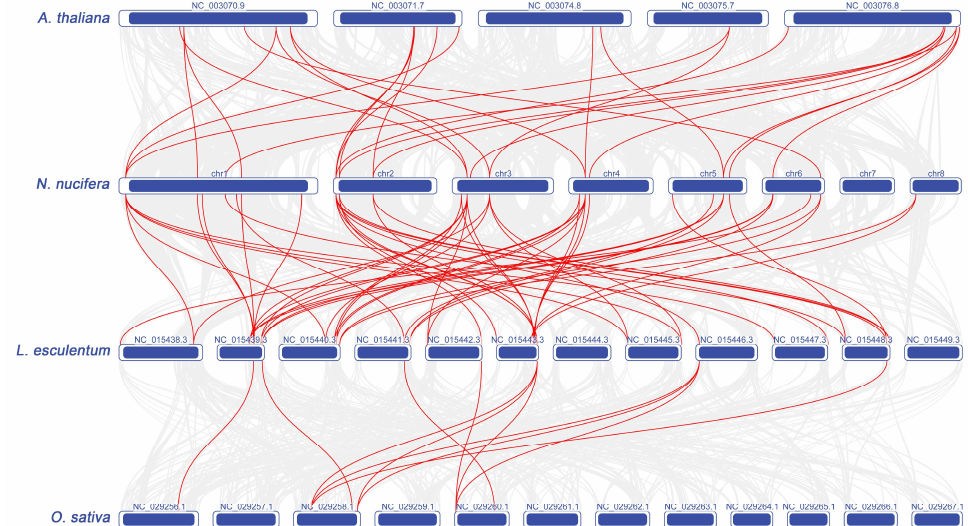
Figure 7. Synthetic analysis of NnDofs in lotus, rice, tomato, and Arabidopsis genomes. The red lines represent homologous gene pairs between two adjacent